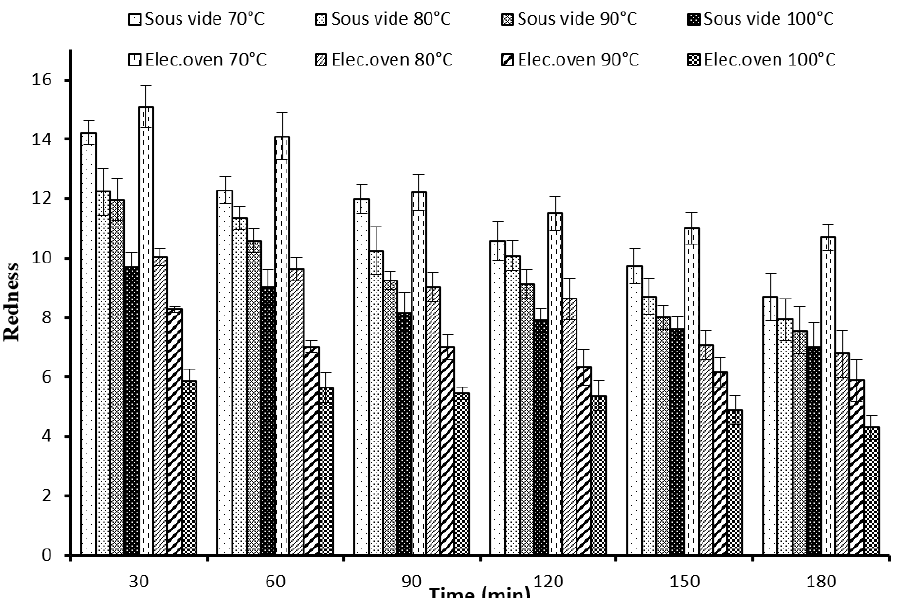
Figure 6. The effect of the cooking method (sous vide vs. electrical oven) on the camel meat color components (redness a*) at different combinations of temperature and time.